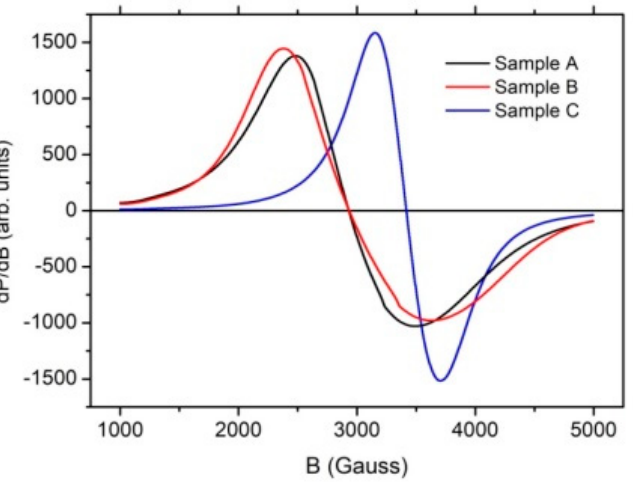
Table 6. Summary of the parameters derived from the EPR spectra. B 0 induction magnetic field corre- sponding the resonance peak. g factor, ∆ B width of the peak. The asymmetry parameter A is defined as the ratio of the height of maximum to the depth of the minimum of the derivative of the peak.